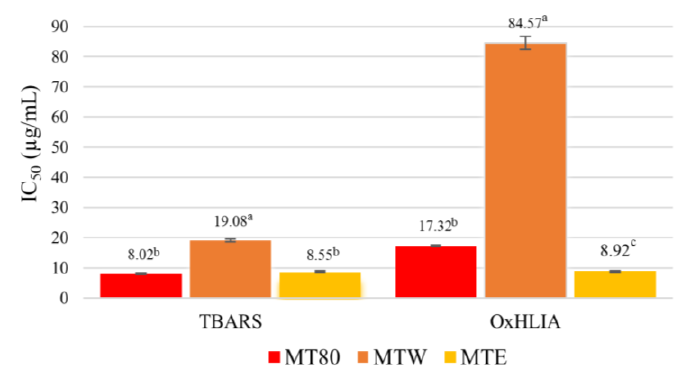
Figure 2. Antioxidant potential of the mangosteen pericarp extracts. Significant differences between samples in the same assay are indicated by different letters on the top of the bars (Tukey HSD test, p < 0.05).